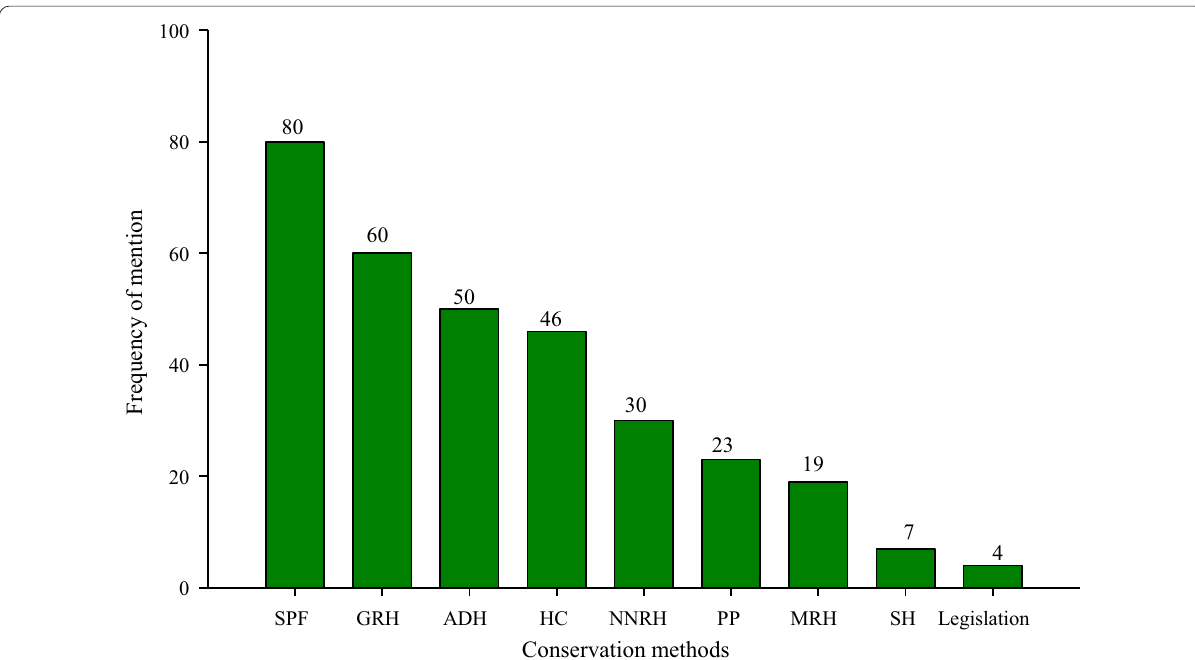
Fig. 3 Conservation strategies of medicinal plants among traditional medical practitioners in selected rural villages in Butaleja District, Eastern Uganda. SPF spiritually protected forests (Engolo), GRH gender restricted harvesting, ADH avoiding destructive harvesting, PP preservation of propagules, SH safeguard from herbivores, HC homestead cultivation, NNRH night and naked restricted harvesting, and MRH mouth restricted